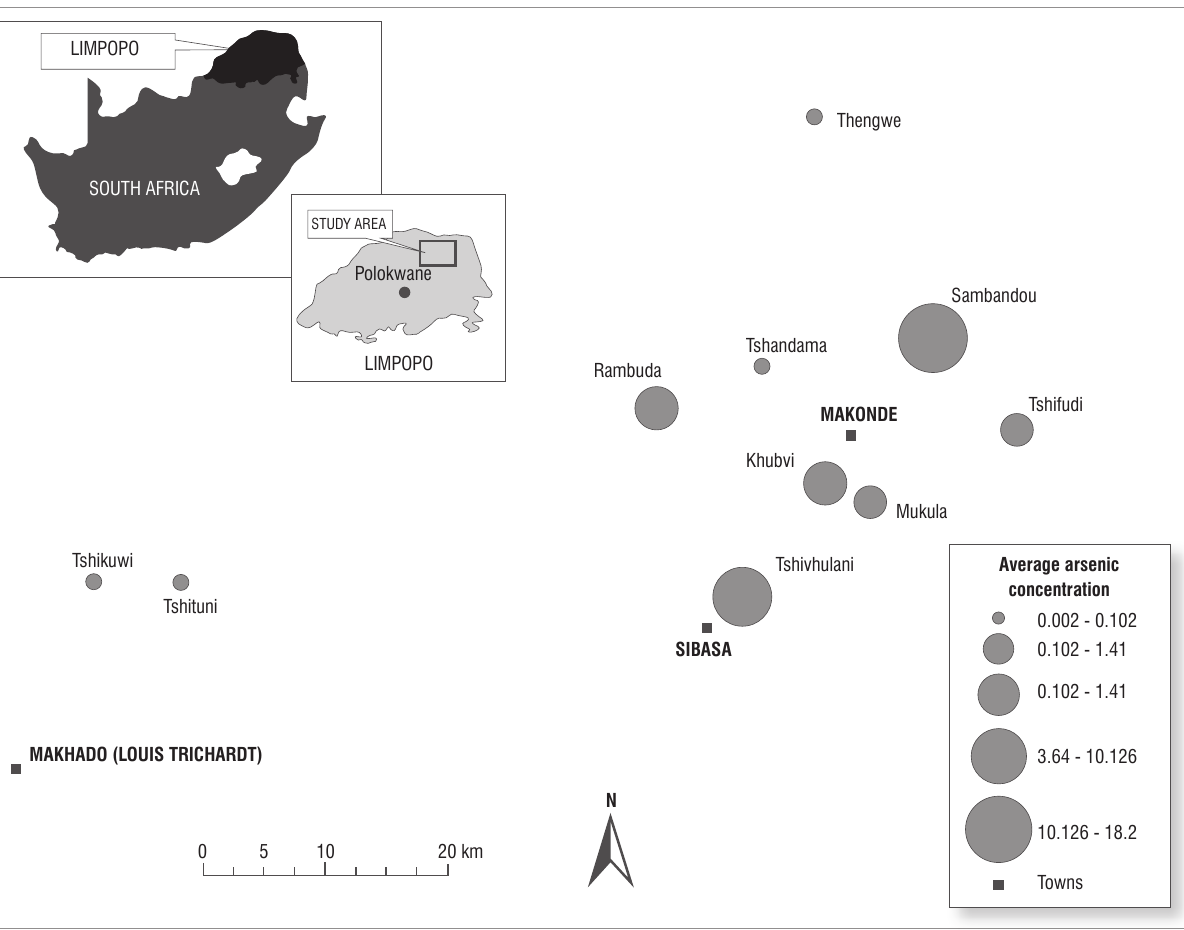
Table 2: Concentration † of arsenic residues in mg/kg at the 10 dip tank sites